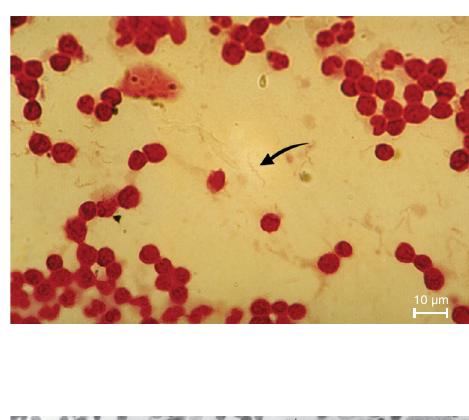
Figure 4. Peripheral blood of a patient with Lyme disease-like syndrome examined by electron microscopy (4200X): (A) Chla- mydia ; (B) Mycoplasma ; (C) Spi- rochete (Prof. Maria de Lourdes Higuchi, Pathology Laboratory, INCOR). Magnification bar =